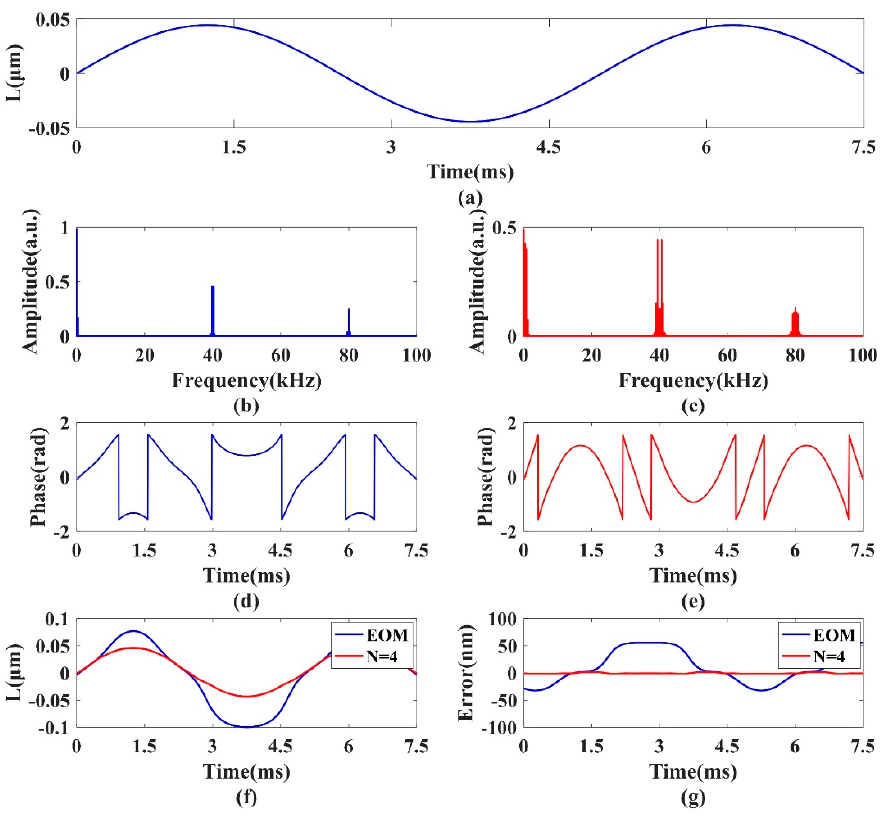
Figure 3. Simulation results of different methods when A = λ /12. ( a ) Simulated displacement of the outer objective. ( b ) Frequency spectrum of SMI signal with EOM-PM. ( c ) Frequency spectrum of SMI signal with MR-PM. ( d ) Wrapped phase from SMI with EOM-PM. ( e ) Wrapped phase of SMI of MR-PM. ( f ) Reconstructed displacement of EOM-PM and MR-PM. ( g ) Displacement reconstruction error of EOM-PM and MR-PM.